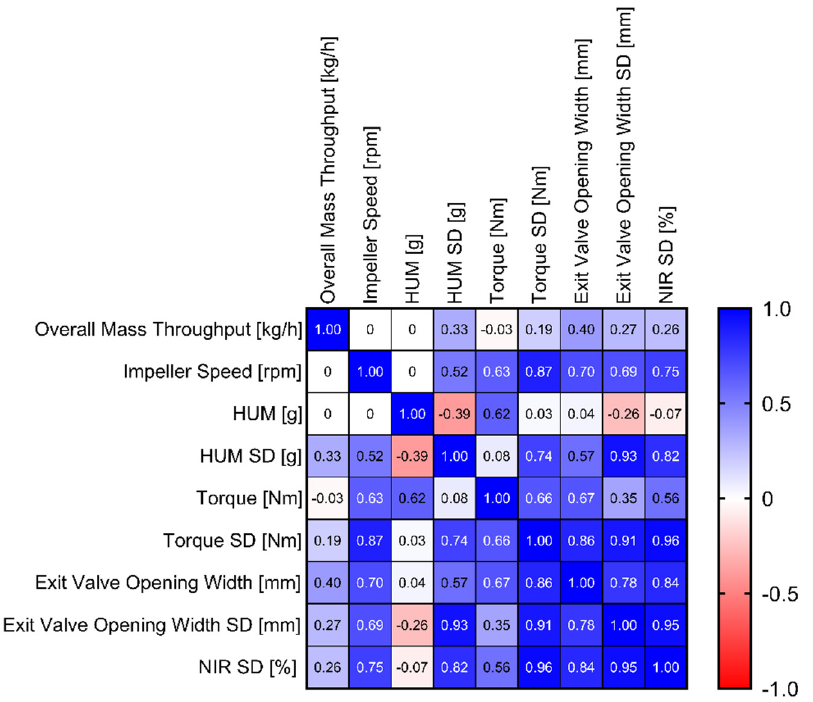
Figure 12. Correlation matrix of input variables and mixing parameters.